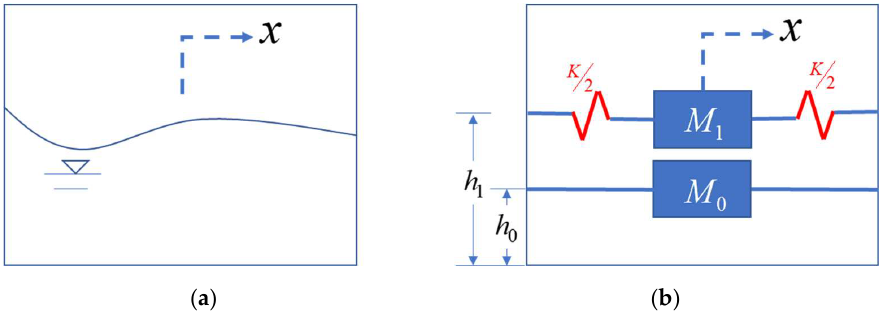
Figure 1. The simplified model of damping theory under the variation on water level. ( a ) The change characteristics of water level motion. ( b ) The simplified mechanical model of water sloshing.